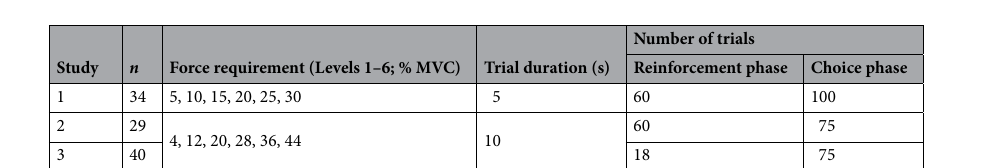
Figure 1. The effort discounting paradigm operationalised effort as the amount of physical force exerted onto a hand-held dynamometer. We defined six levels of force as a proportion of individuals’ MVC (left panel). In the reinforcement phase, participants were familiarised with each of these six levels of force (centre panel). In the choice phase, participants indicated their preferences between the fixed low-effort/low-reward baseline (left of screen) and a variable high-effort/high-reward offer (right of screen) (right panel).